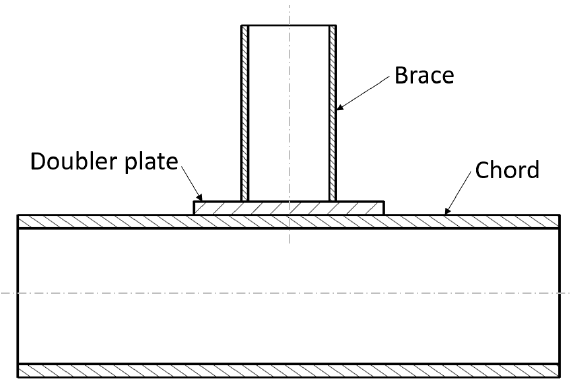
Figure 10. Doubler plate reinforced T-joint.